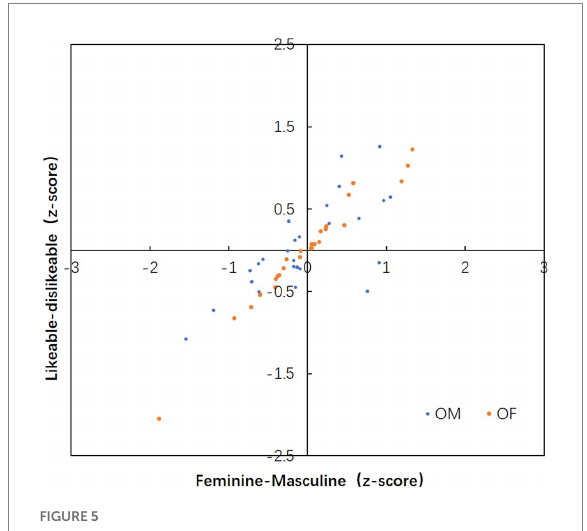
FIGURE 5 The correlation between the feminine-masculine and likeable-